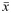
Diversity diagrams of sample sites in the investigation area based on standardized species richness’ and heterogeneities.Living assemblages in light blue, dead assemblages in orange. Species richness based on Chao1 [65] with x¯ = 43.84 and σ = 22.52; heterogeneity based on Evenness [66] with x¯ = 0.573 and σ = 0.203. The blue circle indicates standardized means (x¯ = 0) and standard deviations (σ = 1) for both species richness (abscissa) and heterogeneity (ordinate).